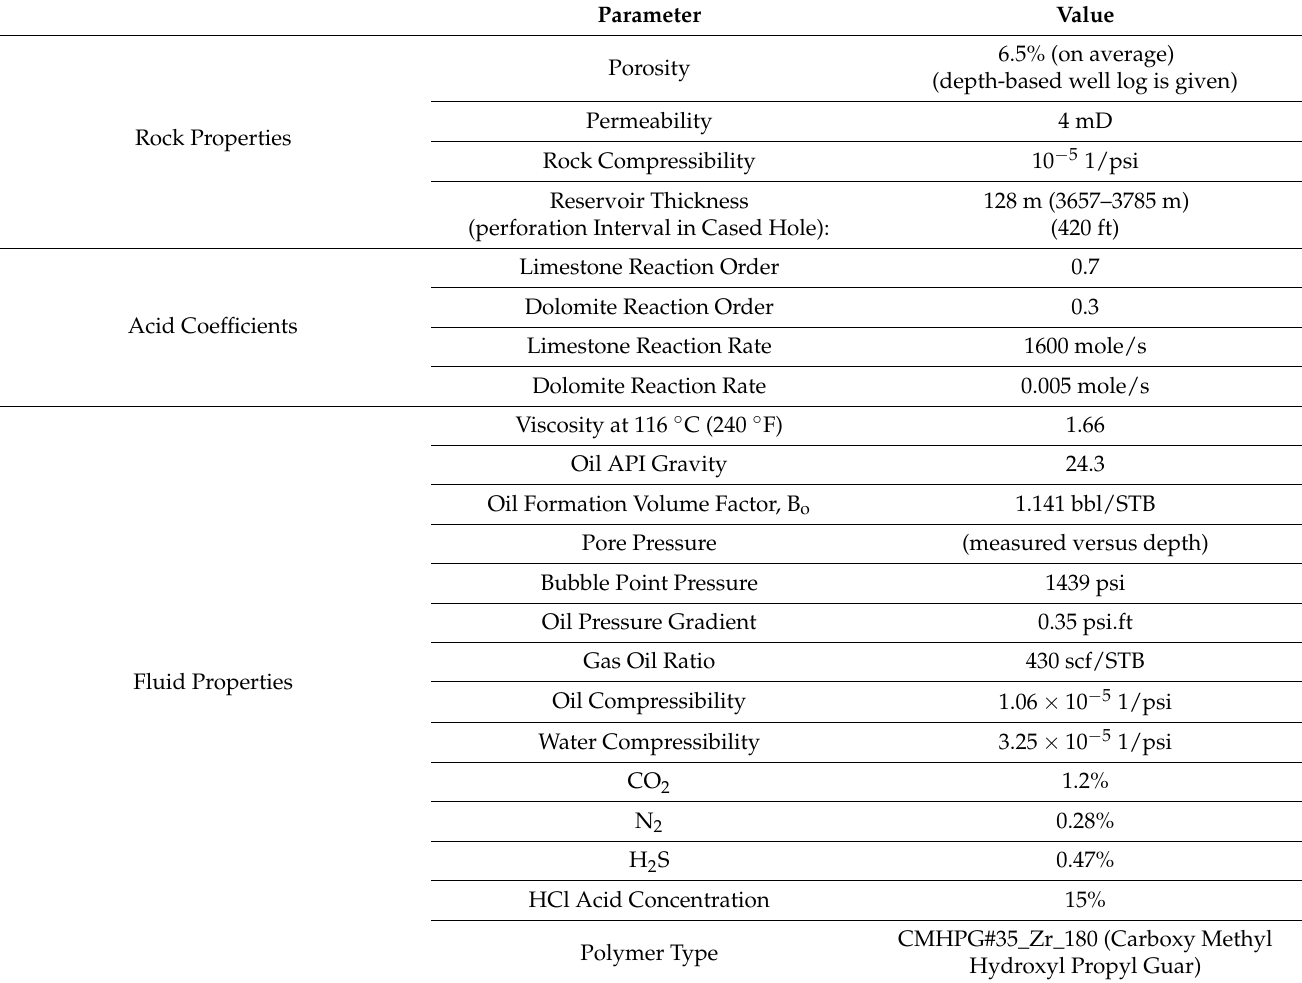
Table 1. Input rock and fluid properties required for optimization of acid fracturing of this work. Parameter